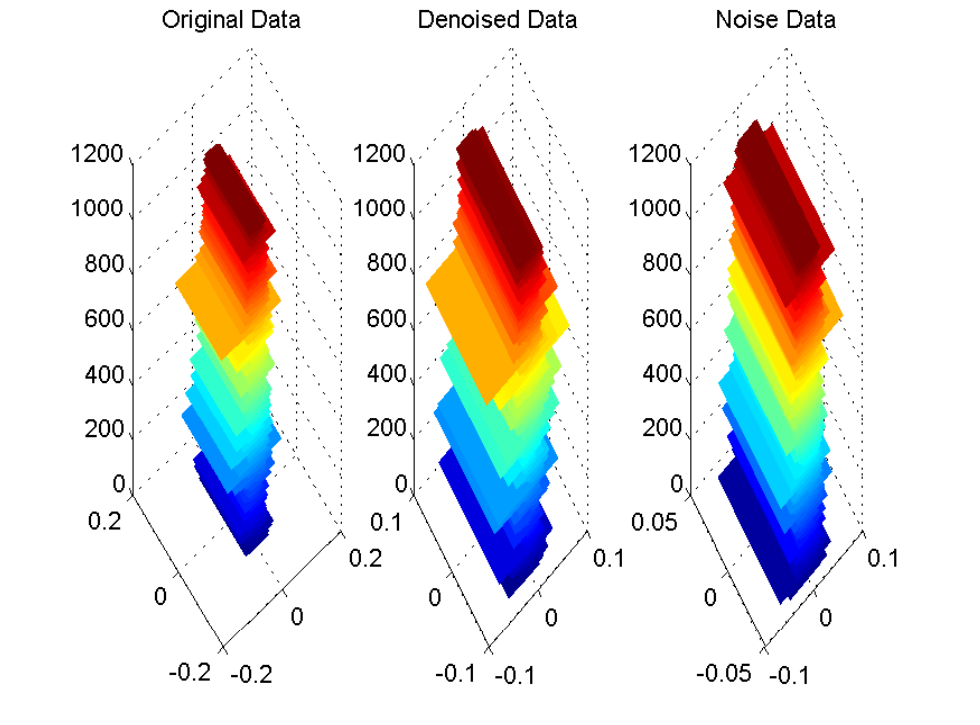
Figure 1. The surf plot of the original, denoised and noise data.